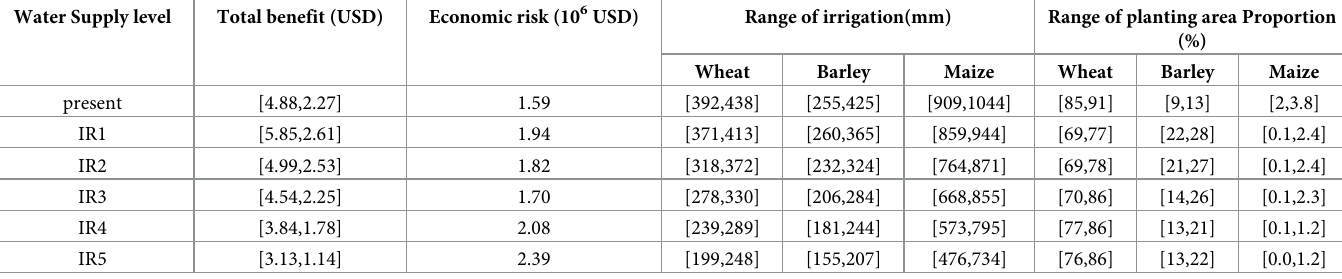
Table 7. Optimized maximum total benefit the average net irrigation depth and planting area proportion for each crop in the irrigation district. Water Supply